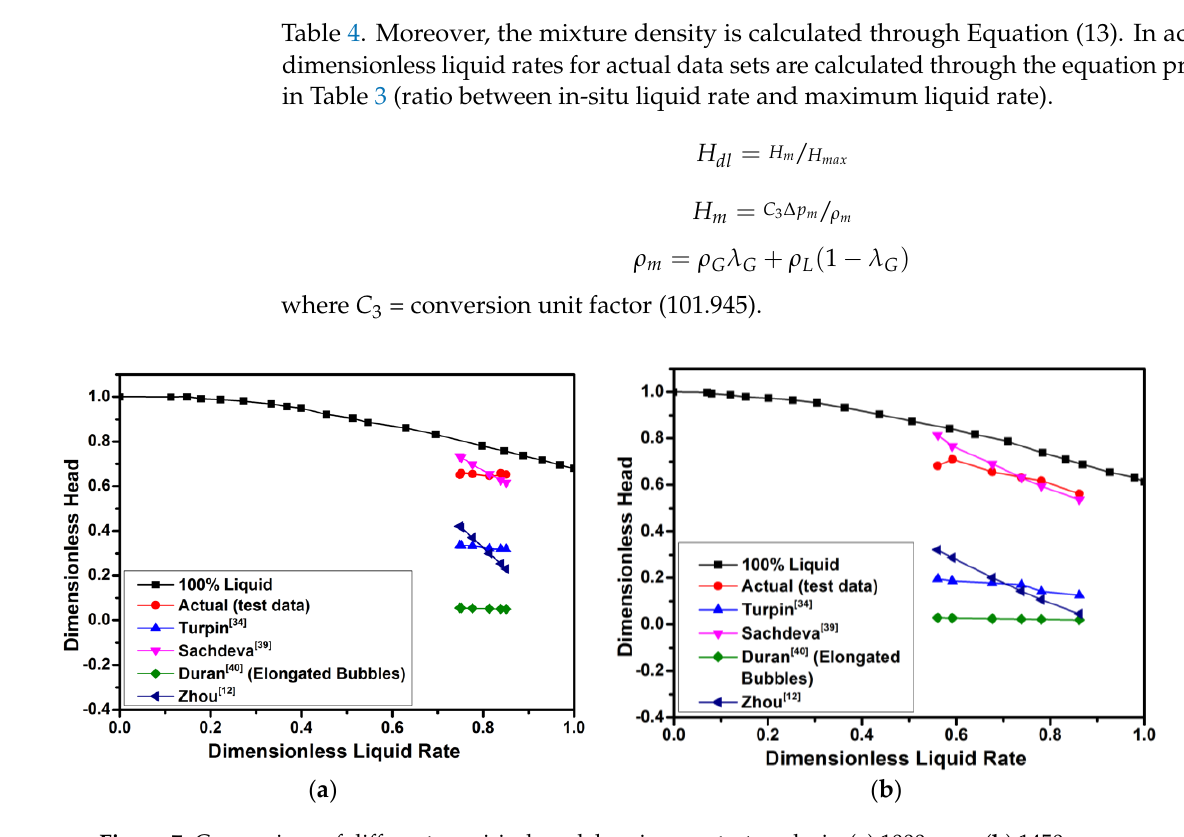
Figure 7. Comparison of different empirical models using our test analysis; ( a ) 1000 rpm, ( b ) 1450 rpm. The dimensionless heads for the rest of the empirical models are calculated through their respective correlations from Table 3. In addition, the previous analysis on the radial flow pump performed by Zhou [12] highlighted that the accuracy of the correlation model is strongly dependent on the pump BEP. According to Zhou [12], if the BEP is greater than 352 m 3 /d, coefficients (K, E1, E2, and E3) for C-72 pump should be used for calculation (Table 3). For smaller radial pumps (<352 m 3 /d), coefficients for I-42B pump are suitable